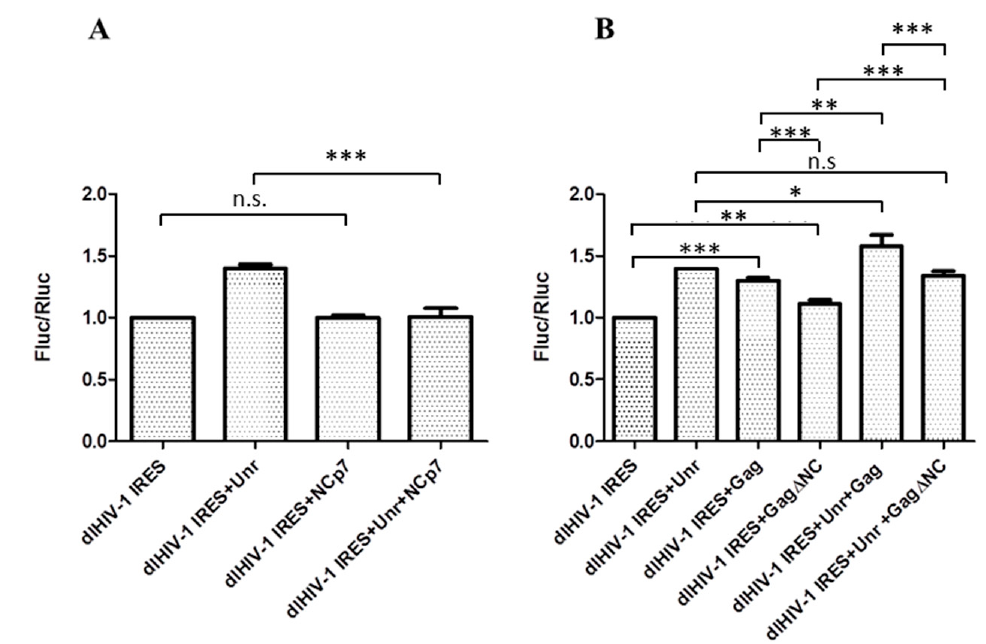
Figure 4. Effect of NCp7 ( A ) and Gag or Gag ∆ NC ( B ) on HIV-1 IRES activity with or without Unr overexpression. The IRES activity is expressed by the ratio of luciferase activities Fluc/Rluc in the dual luciferase assay. The measurements were performed in HeLa cells 24 h post transfection. Histograms represent the mean ± SEM of at least 3 independent experiments done in triplicate. n.s.—non-significant. * p < 0.05; ** p < 0.01; *** p < 0.001.